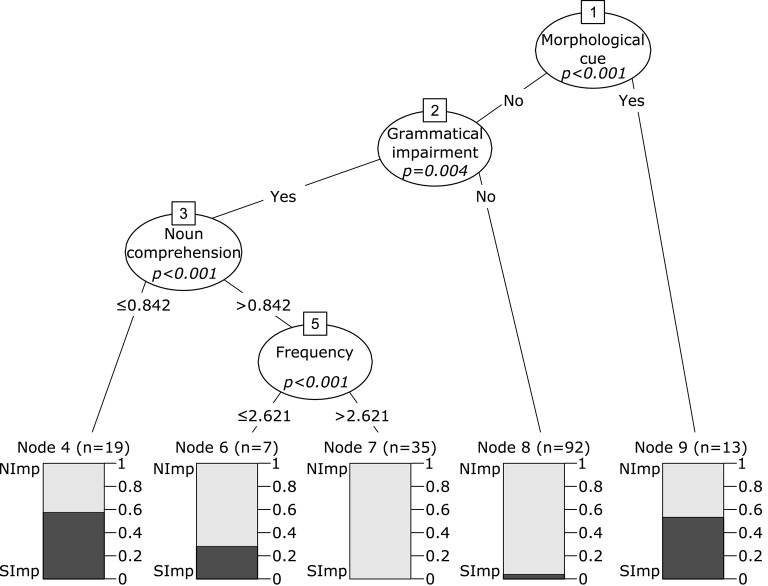
Conditional inference tree for treatment outcome for untreated verbs. Nodes 1, 2, 3, and 5 represent significant variables, with p-values presented within the node. Below each of these nodes, the values represent the points at which the node splits, therefore separating patients in groups with different outcome predictions. Each of these groups is represented by a box, and the colors in the box represent the proportion of patients within each group that showed significant improvement after treatment (SImp, in dark gray) and the proportion of patients that did not (NImp, in light gray).